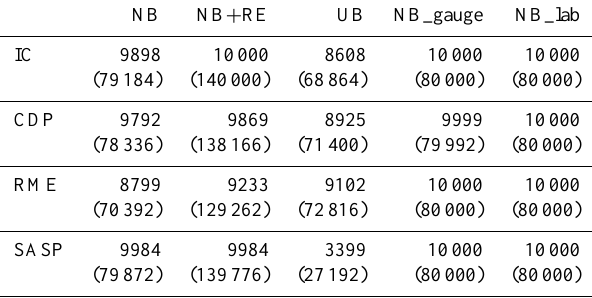
Table 4. Number of samples ( N ) and model simulations (in paren- theses) meeting the requirements for minimum peak SWE and snow duration and valid snow disappearance dates at each site (rows) in each scenario (columns). The number of model simulations scaled as N ( k + 2), where k = 12 in scenario NB + RE and k = 6 in all other scenarios. When a simulation was rejected, all related simulations (based on resampling) were also